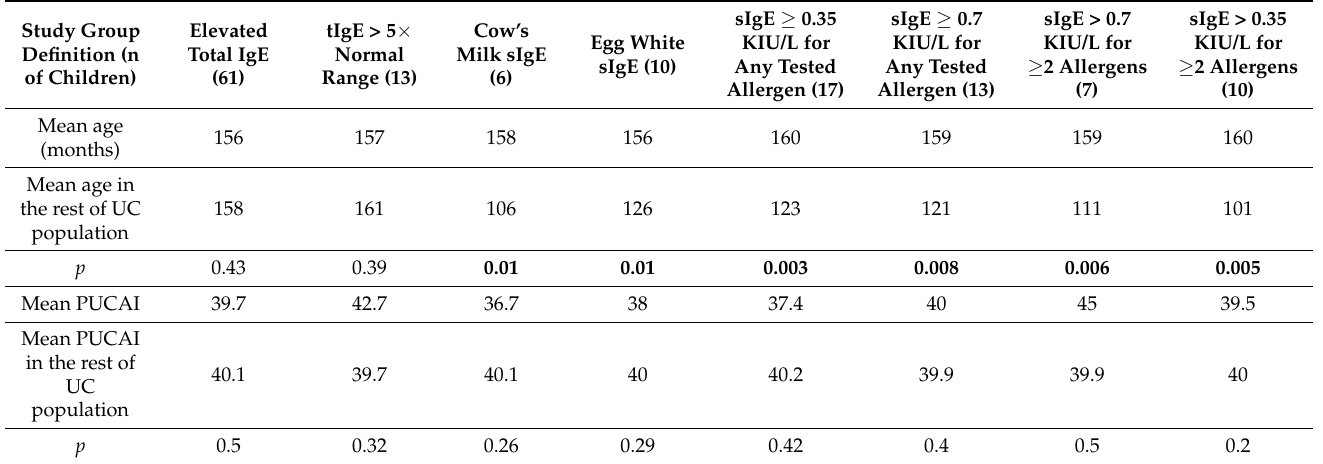
Table 1. UC—age and PUCAI in subpopulations. Statistically significant correlations are presented in bold